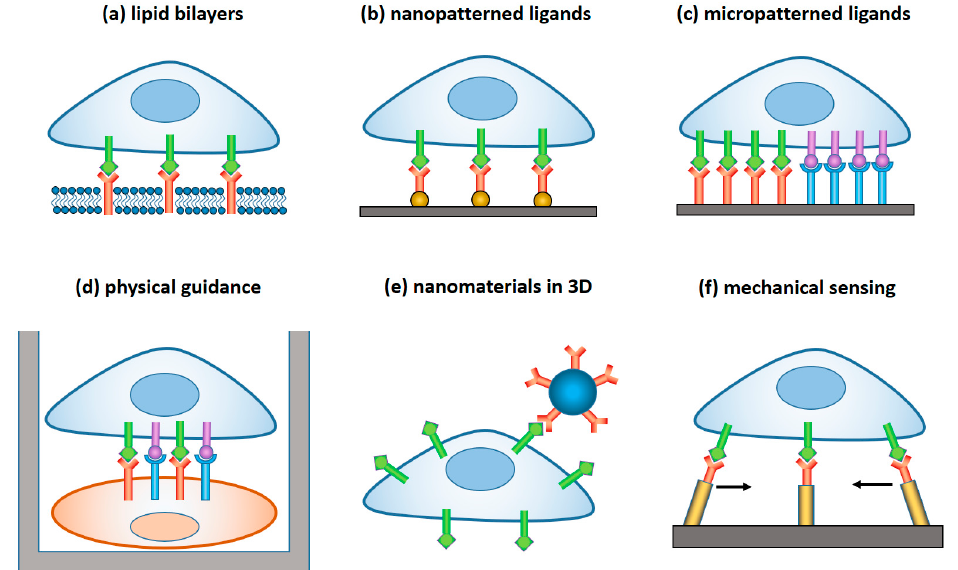
Figure 2. Advanced materials and devices for the study and regulation of NK cells: ( a ) Lipid bilayer with incorporated ligands that mimic the surface of target cells. ( b ) Ligands tethered to a pattern of nanodots that determine arrangement individual receptors onto a fixed 2D architecture. ( c ) Surface with ligand micropatterns that determine receptor clustering. ( d ) Devices for physical guidance and confinement of NK cells, alone as well as in a pair with target cells. ( e ) Nanomaterials for controlled ligand delivery on 3D ( f ) devices for mechanical stimulation of NK cells. Activating or inhibitory ligand-receptor pairs are schematized as in Figure 1.